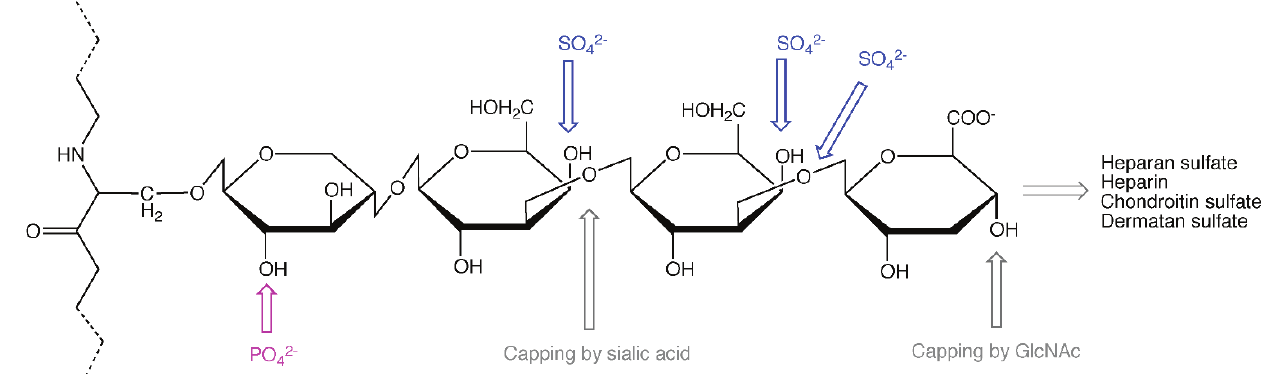
Figure 1. A heparan sulfate (HS)/heparin or chondroitin sulfate (CS)/dermatan sulfate (DS) attachment site in a proteoglycan (PG) protein core with a linker tetrasaccharide. Sulfation, phosphorylation and capping sites are